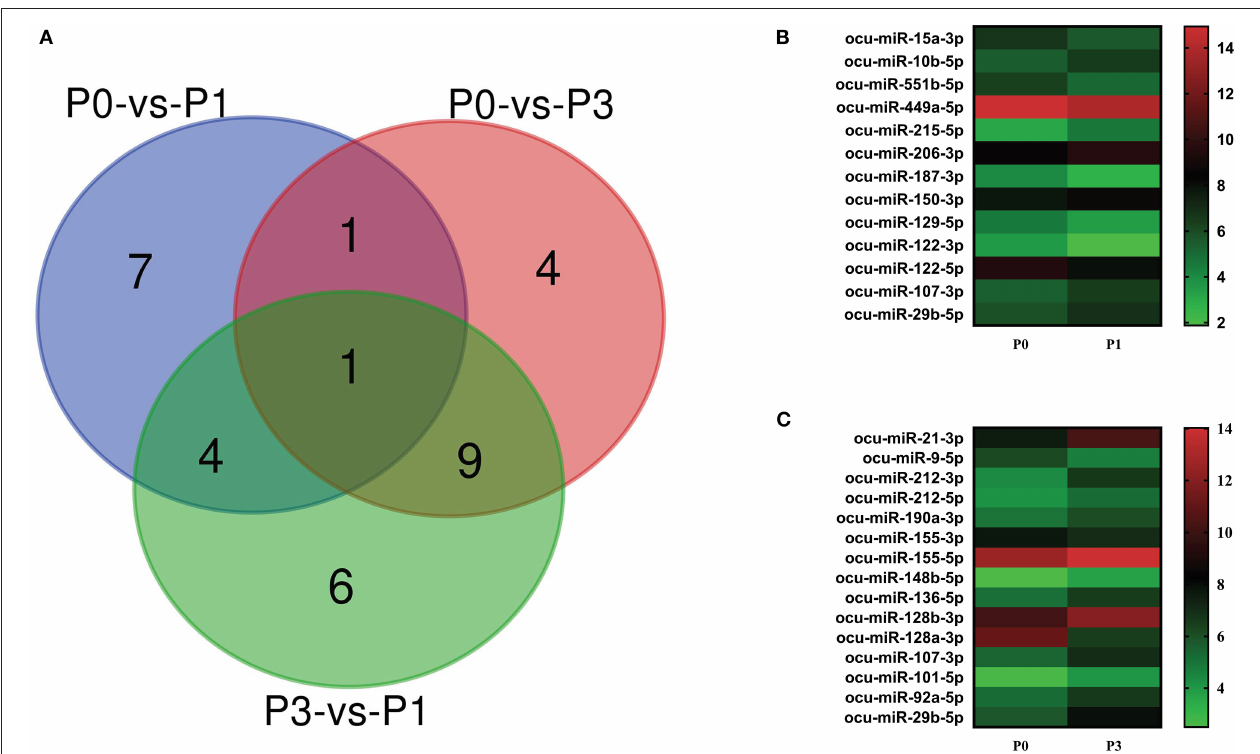
FIGURE 3 | (A) Venn diagram showing the DE miRNAs in the three comparison groups: P0-vs-P1, P0-vs-P3, and P3-vs-P1. Heat map analysis of DE-miRNAs. Based on the sequenced FPKM data from rabbit lung at 1 dpi (B) and 3 dpi (C) with P. multocida , compared to unchallenged controls (0 dpi). Heat map was drawn using GraPhpad Prism 8 software. Red indicates higher relative expression and green indicates lower relative expression. From bottom to top, the |log2(FC)| gradually increased.